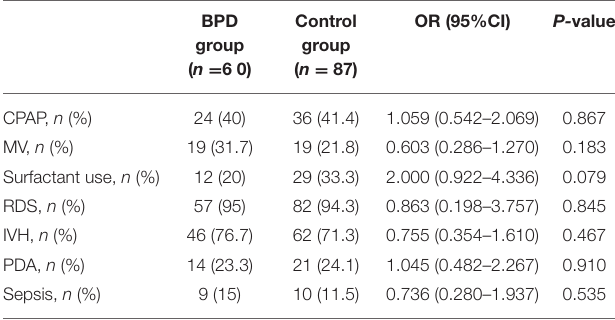
TABLE 3 | Univariate regression analysis of neonatal characteristics and clinical outcomes of infants with BPD and controls. BPD